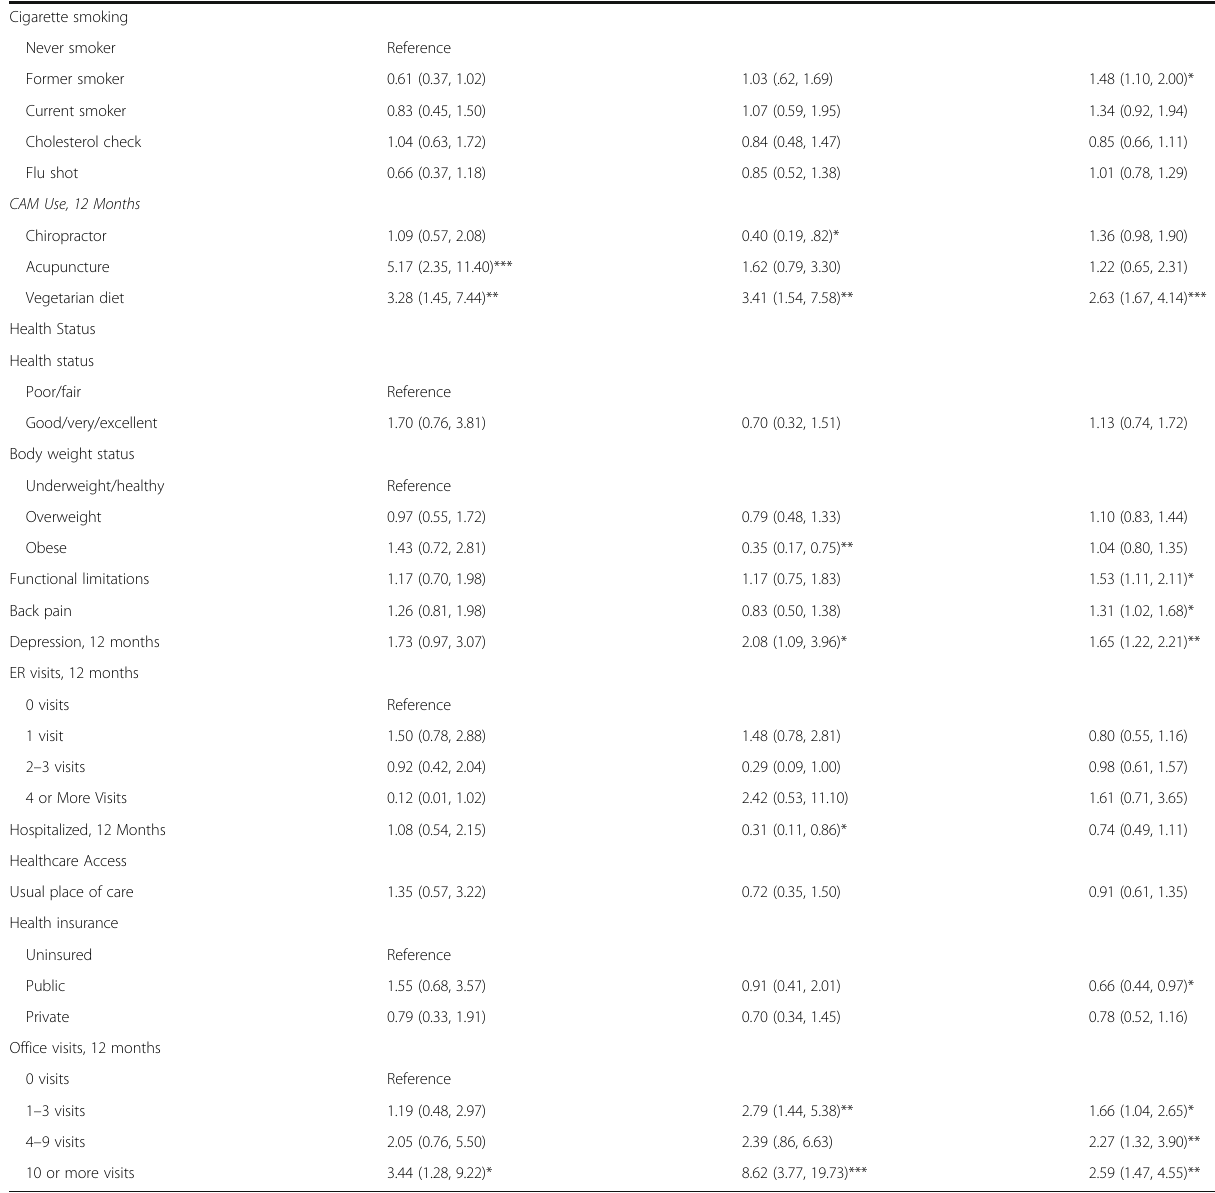
Table 3 Multivariable logistic regression predicting meditation practices, exclusive use of one meditation style during the previous 12 months